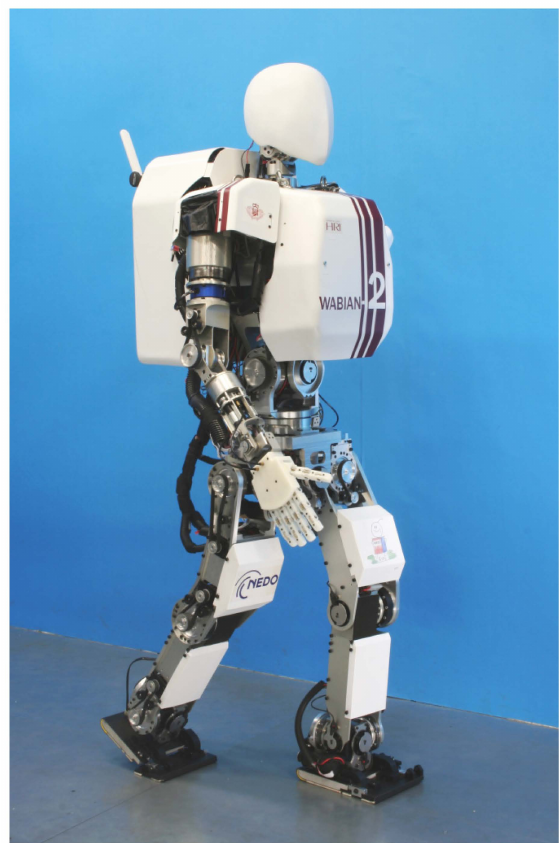
Figure 1. The WABIAN-2R.